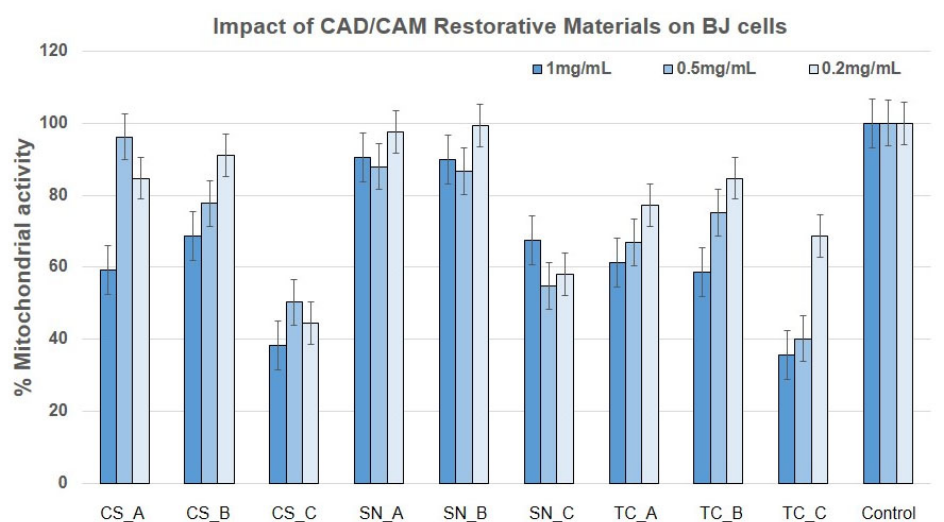
Figure 6. Mitochondrial activity percentage of BJ human cells, after treatment with nonexposed/exposed to acidic artificial saliva of CAD/CAM restorative materials powders.